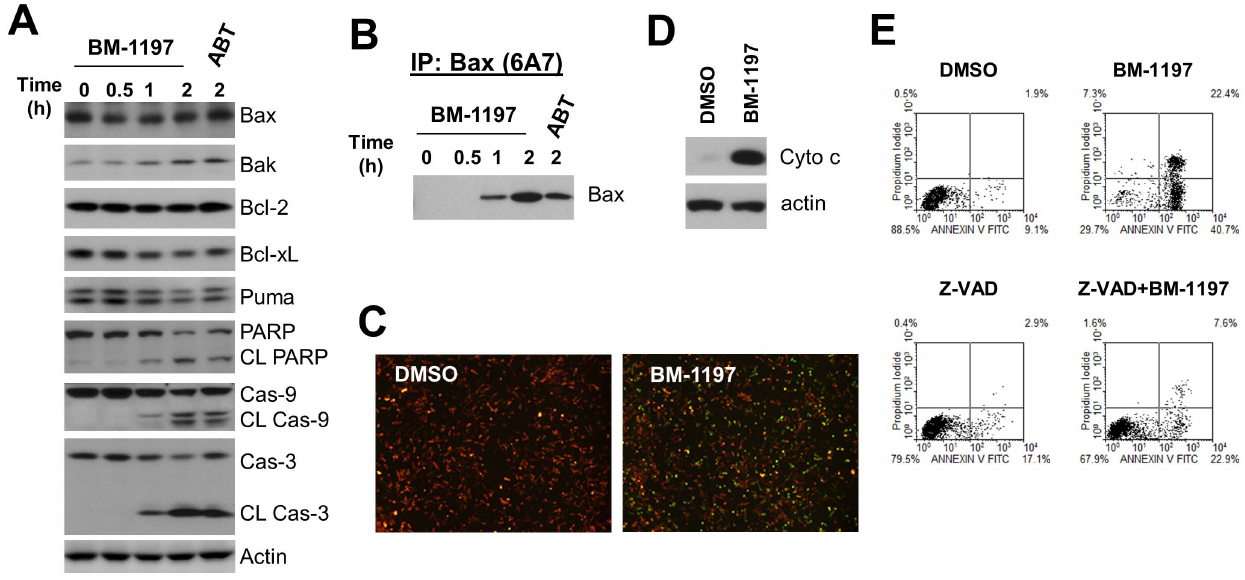
Figure 5. BM-1197 induces BAX translocation and cytochrome c release in MEF/ MCL1 2 / 2 cells. (A) Cells were treated with BM-1197 (50 nM) or ABT-263 (50 nM) for the indicated time points and whole cell extracts were analyzed by immunoblotting. (B) CHAPS lysed whole cell extracts from BM-1197 (50 nM)-treated MCL1 2 / 2 cells were immunoprecipitated with conformation-sensitive Bax specific antibody 6A7, and immunoprecipitates were analyzed for Bax by immunoblotting. (C) MCL1 2 / 2 cells were treated with BM-1197 (50 nM) for 30 min, then co-incubated with JC-1 (2 m g/ml) for an additional 30 min. Representative images are shown. (D) MCL1 2 / 2 cells were treated with BM-1197 (50 nM) for 1 h and cytosolic fraction was isolated for immunoblotting. (E) MCL1 2 / 2 cells were pretreated with DMSO or 40 m M of Z-VAD for 2 h, then treated with 100 nM of BM-1197 for 16 h and stained with Annexin V/PI for flow cytometry analysis.